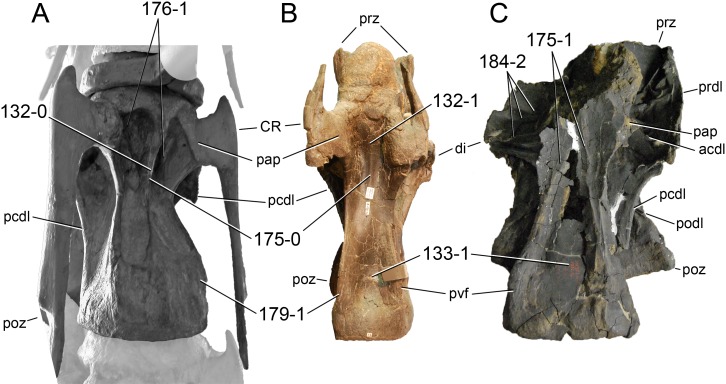
Flagellicaudatan mid- to posterior cervical vertebrae.Mid- to posterior cervical vertebrae of Dicraeosaurus hansemanni MB.R.4886 (A; photo by J Harris), Kaatedocus siberi SMA 0004 (B), and Barosaurus lentus YPM 429 (C) in ventral view (anterior to the top). Note the different developments of the ventral keels (prominent in Dicraeosaurus, A, C132-0; shallow, single in Kaatedocus, B, C132-1 and 175-0; double in Barosaurus, C, C175-1), the ventral sulcus typical for diplodocines (B, C; C133-1), the pneumatic foramina accompanying the ventral keel in Dicraeosaurus (A; C176-1), the posteroventral flanges (C179-1), and the numerous accessory laminae subdividing the prezygapophyseal centrodiapophyseal fossa in Barosaurus (C; C184-2). Vertebrae scaled to same centrum length. Abb: acdl, anterior centrodiapophyseal lamina; CR, cervical rib; di, diapophysis; pap, parapophysis; pcdl, posterior centrodiapophyseal lamina; podl, postzygodiapophyseal lamina; poz, postzygapophysis, prdl, prezygodiapophyseal lamina; prz, prezygapophysis; pvf, posteroventral flange.